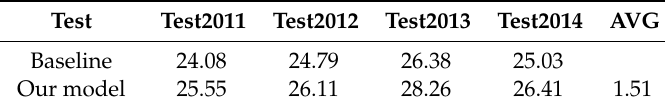
Table 3. The BLEU scores of the TR–EN translation task.